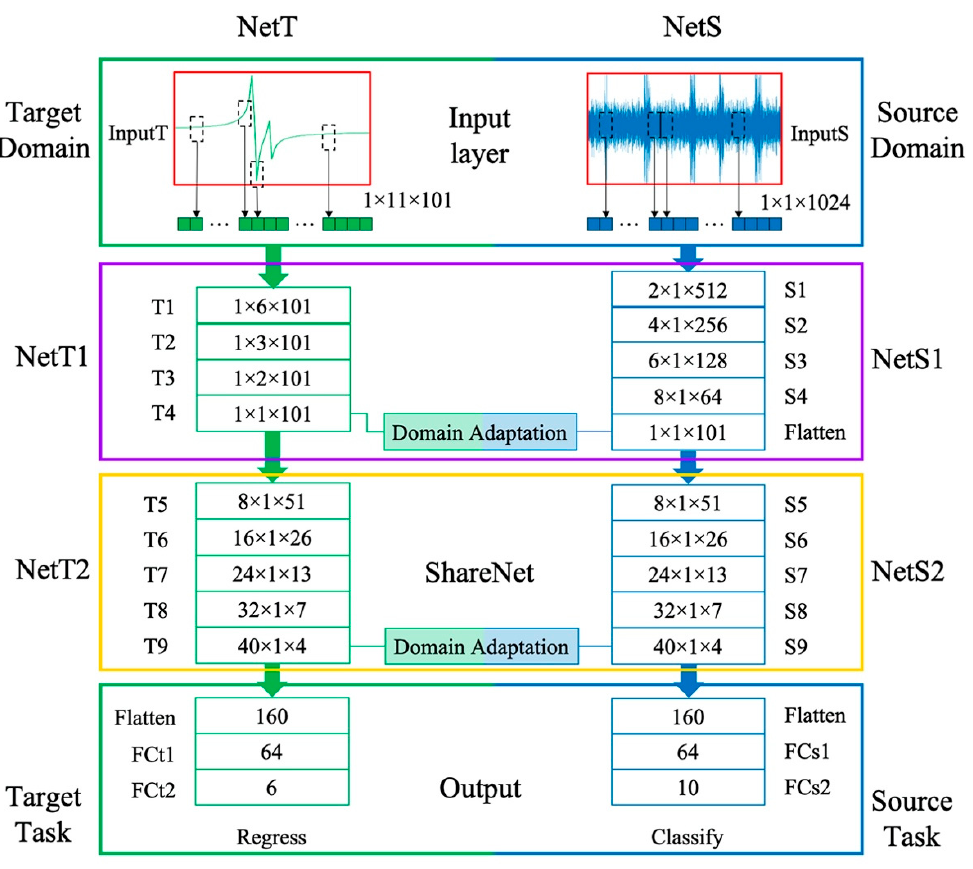
Table 1. Details of the proposed network.